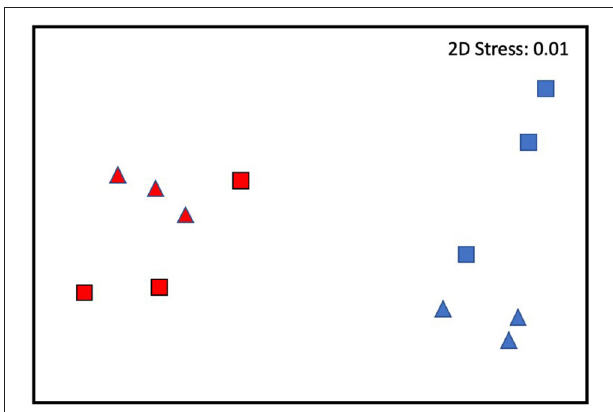
FIGURE 4 | Current MHWs. nMDS of the interaction between Time and Site: red, warm site; blue, cold site; triangles, T2; squares, T3.